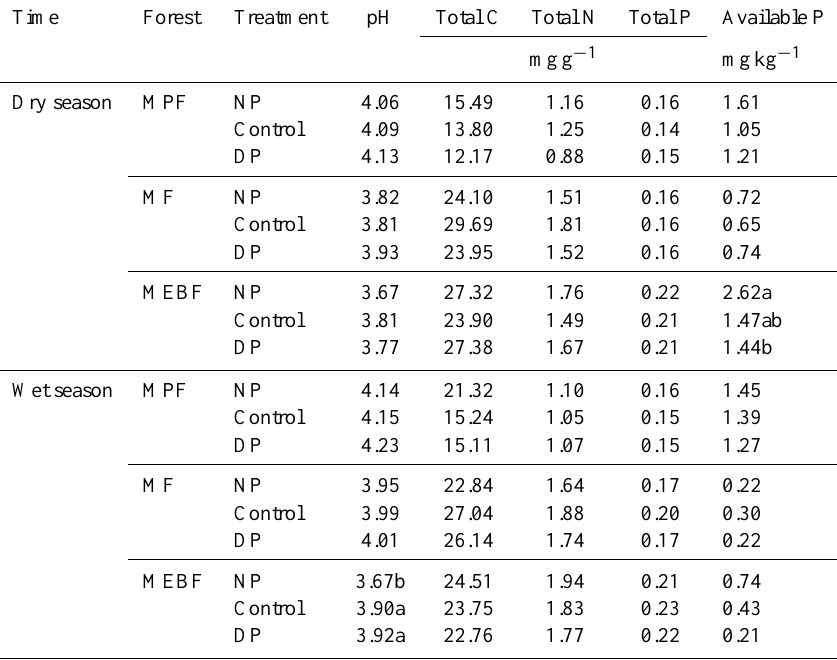
Table 2. Soil chemical properties and their responses to precipitation treatments in 0–20cm mineral soils of three forests in the dry and wet seasons at Dinghushan Biosphere Reserve. Mean values within a column in each forest for each season followed by different lowercase letters have significant treatment differences at P < 0 . 05. MPF, Masson pine forest; MF, coniferous and broad-leaved mixed forest; MEBF, monsoon evergreen broad-leaved forest. NP, no precipitation; Control, natural precipitation; DP, double